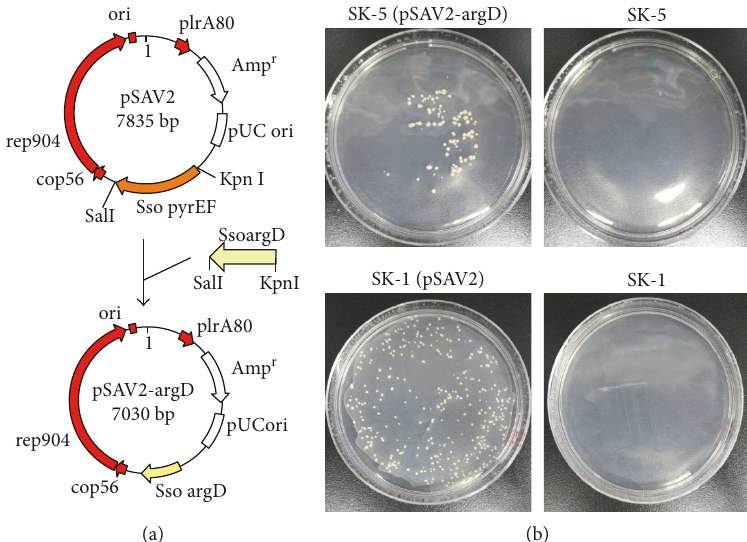
Figure 8: Development of a transformation system based on agmatine selection for S. acidocaldarius . (a) Construction of pSAV2-argD. The S. solfataricus pyrEF operon was replaced by a 0.6kb S. solfataricus argD marker. The resulting vector was named pSAV2-argD. (b) Transformation of the argD deletion mutant SK-5 with pSAV2-argD. Plating of SK-5 ( Δ pyrE Δ suaI Δ argD ) transformed with 8ng of plasmid DNA of pSAV2-argD (SK-5 [pSAV2-argD]) on an XTU plate at 75 ° C for 10 days and SK-1 ( Δ pyrE Δ suaI ) transformed with 8ng of plasmid DNA of pSAV2 (SK-1 [pSAV2]) on an XT plate at 75 ° C for 7 days are shown. Controls (SK-1 and SK-5) included competent cells without plasmid DNA and